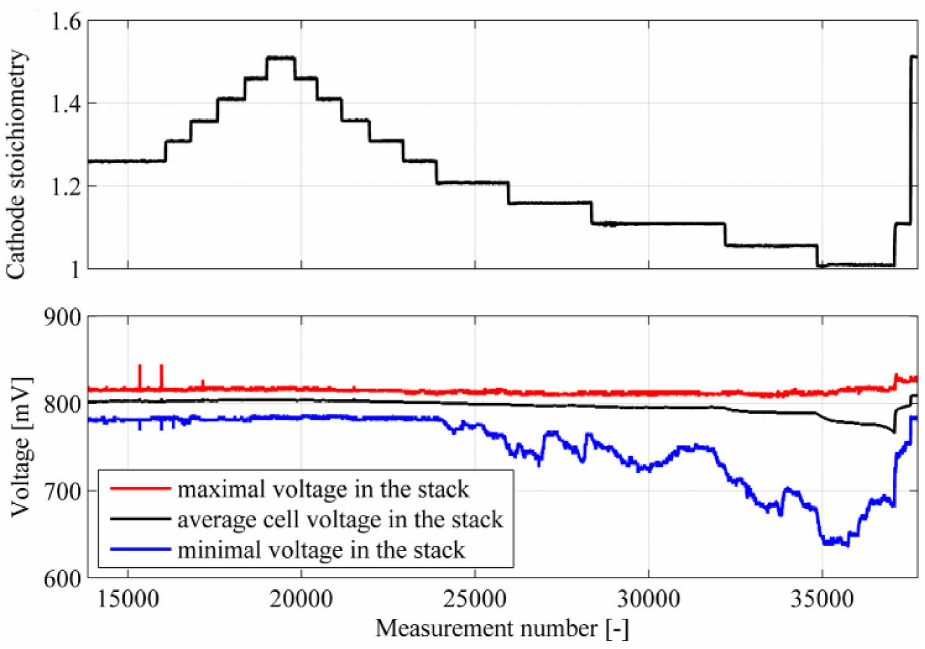
Figure 6. Effect of cathode stoichiometry on cell voltage